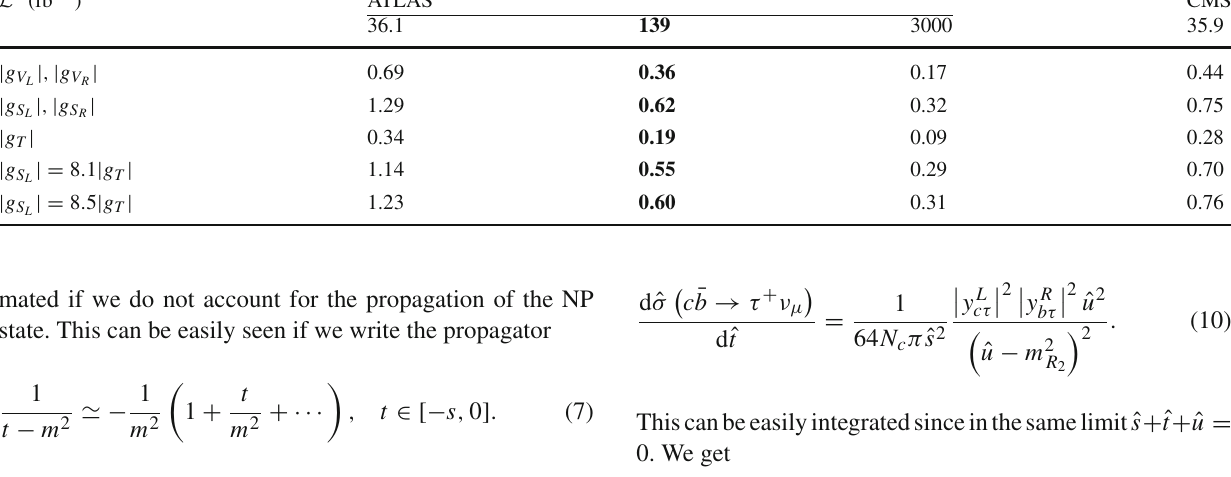
Table 2 Same as in Table 1 but with the inclusion of systematic error on the τ reconstruction efficiency. See Sect. 3 for details L ( fb − 1